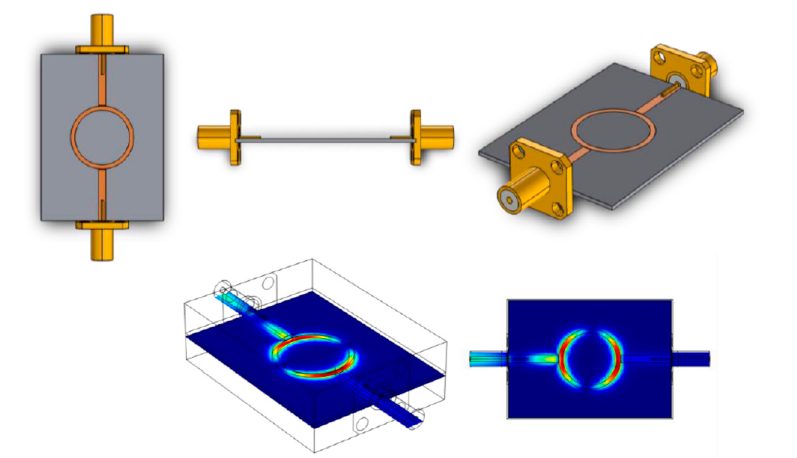
Figure 1. Typical setup ( top ) and modeled field distribution by COMSOL Multiphysics ( bottom ). Later, the ring area was covered by the sensitive functional material (zeolite).